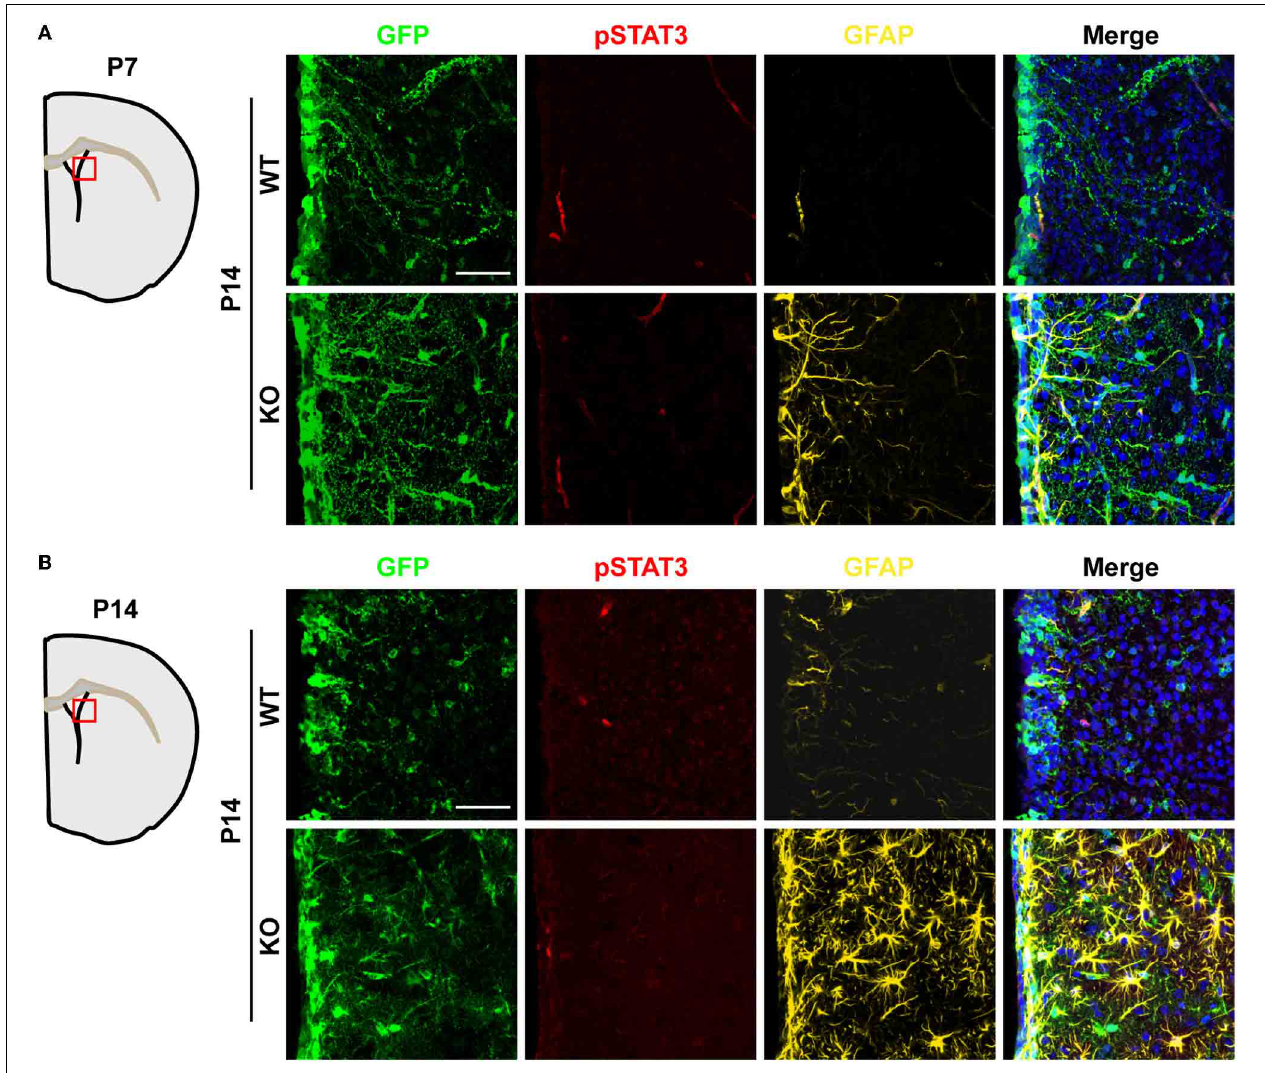
FIGURE 6 | Unaltered JAK-STAT3 signaling in Tlx -mutant brains. JAK-STAT3 signaling was monitored by immunohistochemistry with an antibody for phosphorylated STAT3 at tyrosine 705 (pSTAT3).